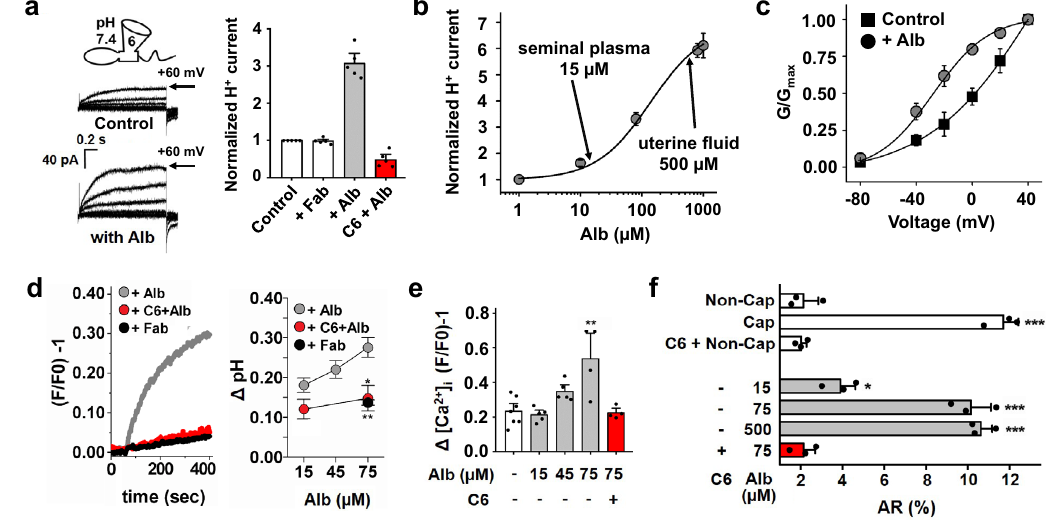
Fig. 1 Alb activates hHv1 in human sperm to initiate capacitation and allow the acrosome reaction. a Left, Proton current traces in non-capacitated human sperm in the absence (top) and presence (bottom) of 80 μ M Alb (20 mV steps from − 60 and + 60 mV). Right, hHv1 currents at the end of a test pulse to + 60 mV with 80 μ M Fab (white bar), 80 μ M Alb (gray bar), or 80 μ M Alb + 1 μ M C6 (red bar). Values are normalized to mean current amplitude without Alb. C6 peptide blocked 86 ± 3% of the Alb-activated current, n = 5 cells. b Dose-response relationships for Alb potentiation of sperm proton current at + 60 mV. The half-maximal effective concentration (EC 50 ) of Alb activation estimated from the fi t to Hill relationship as 158 ± 16 µ M with